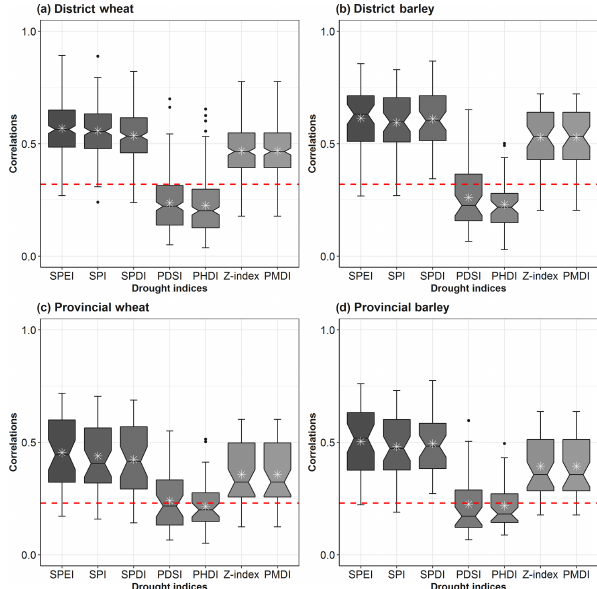
Figure 3. Box plots showing the strongest correlation coefficients found between drought indices and wheat and barley yields at the agricultural district ( a and b ) and provincial ( c and d ) scales, for all districts and provinces analyzed. The solid black line shows the median, the white asterisk shows the mean, and the dashed red lines show the p < 0 . 05 significance